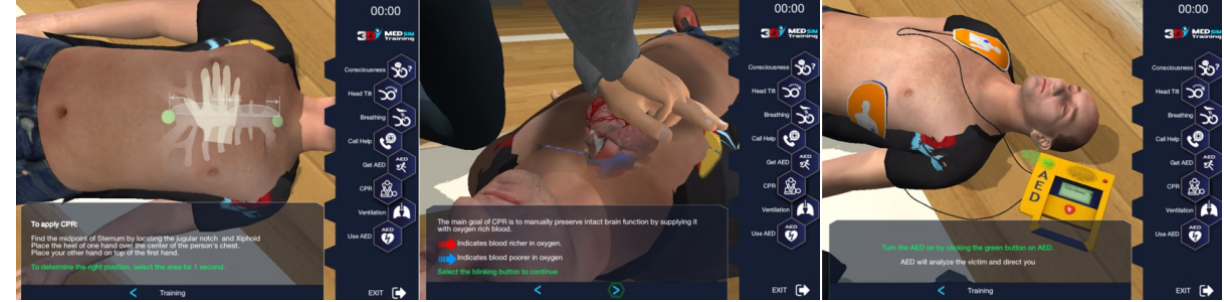
Figure 2. Screen captures from the Basic Life Support Serious Game